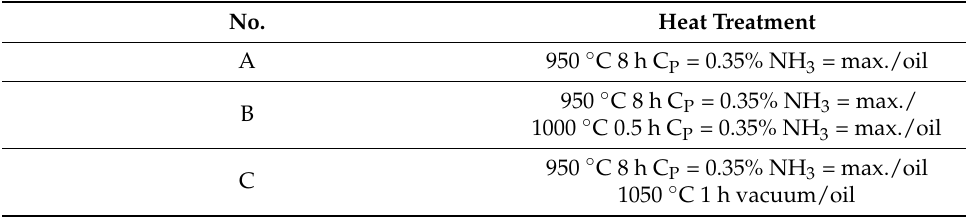
Table 2. Heat treatment parameters for the carbonitriding of the material X38CrMoV5-3.